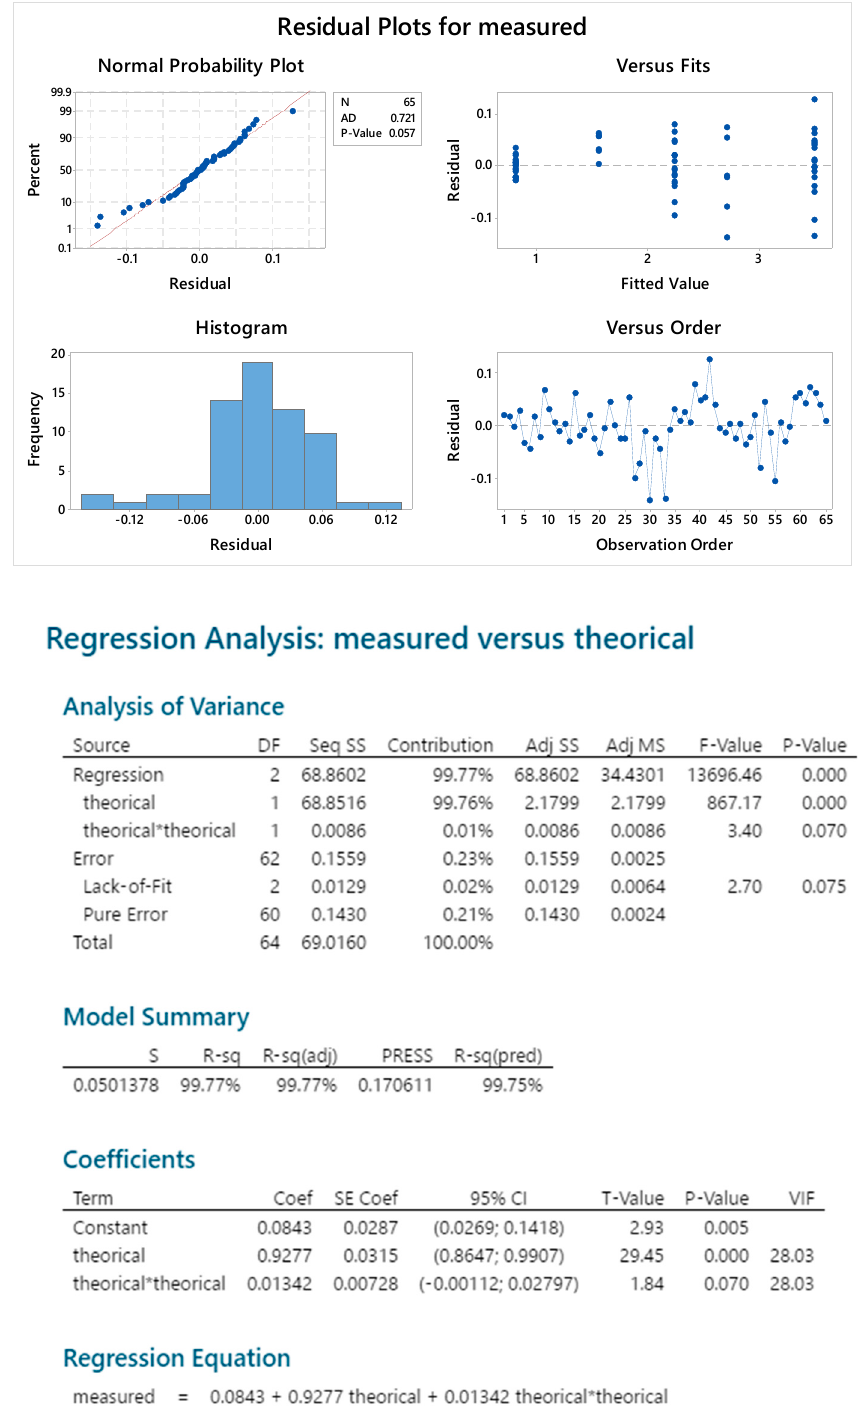
Figure A15. Quadratic regression analysis for sample linearity in of S. flexneri 6 OAg assay by HPAEC-PAD (data from six analysis sessions together).